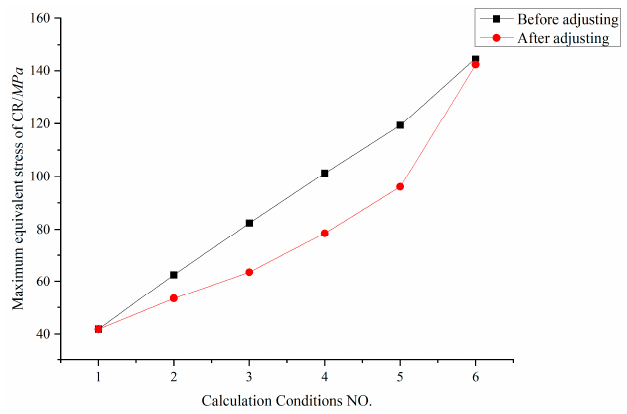
Figure 44. Maximum equivalent stress of CR before and after adjusting. Four representative tie-downs are selected: axis 1 (long axis), axis 5, axis 8 (45 ◦ ), and axis 15 (short axis). The changes in cable force under various tension conditions before and after adjusting were drawn as cable force curve, shown in Figure 45. The slight difference in cable forces indicates that additional tooling cables will not be wasted due to different tension strategies of tie-downs.